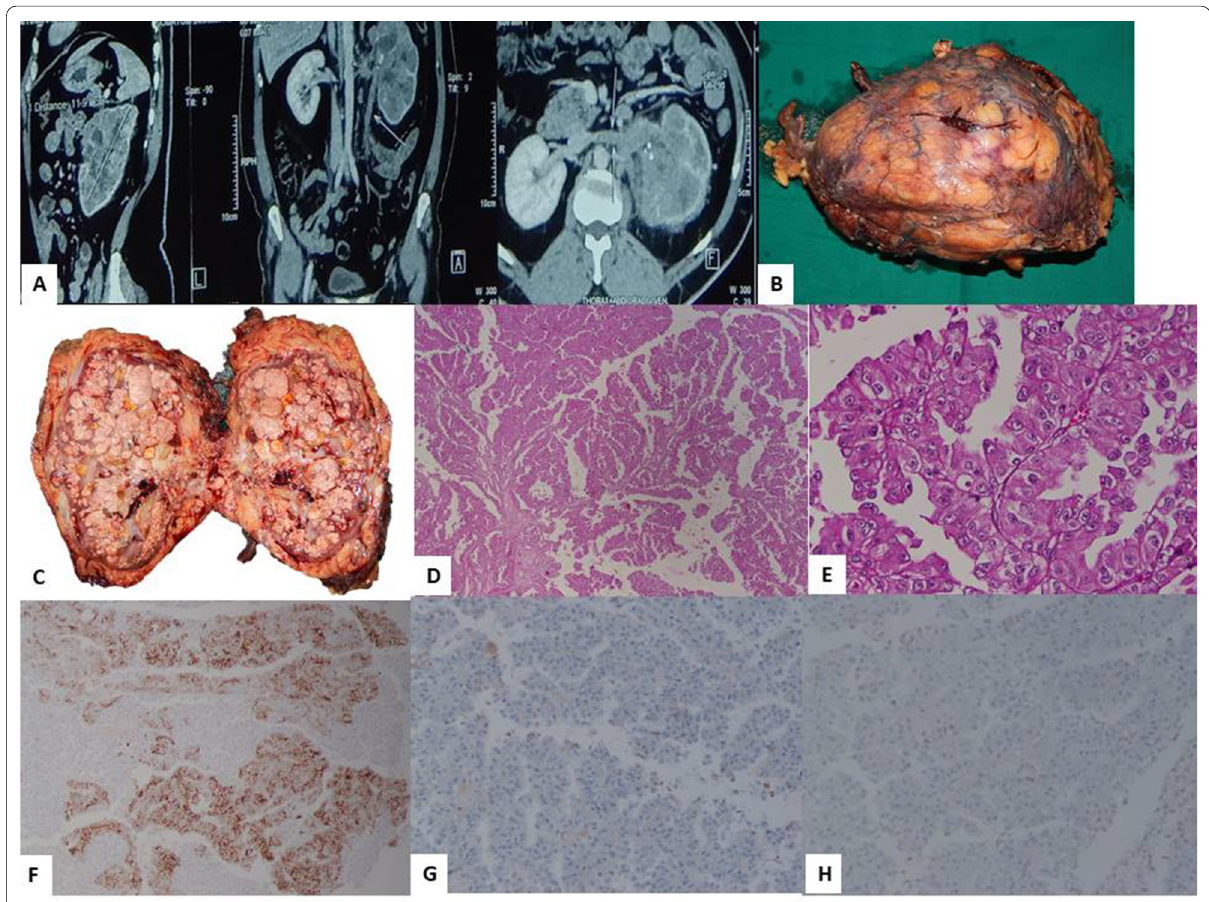
Fig. 2 A 9.6 * 8.9 * 13.9 cm heterogeneously enhancing lesion completely involving left renal parenchyma, perinephric fat stranding and nodularity, focal areas of extracapsular extension, involvement of renal pelvis and ureter, tumoral thrombus extending into infrahepatic IVC, no contrast excretion, enlarged L.N in preaortic and paraaortic, largest 2.1 * 1.4 cm, liver and lung lesions. B , C 21 * 12 * 10 cm gross kidney specimen, weighing 1103 gm. Diffusely infiltrative grayish pink tumors with areas of necrosis and focal calcification. D , E Low power and high power microscopic images showing predominantly papillary type 2 tumor composed of papillary fronds covered with eoisnophilic tumor cells. F CK 20 positive. G CK 7 negative. H CA 9